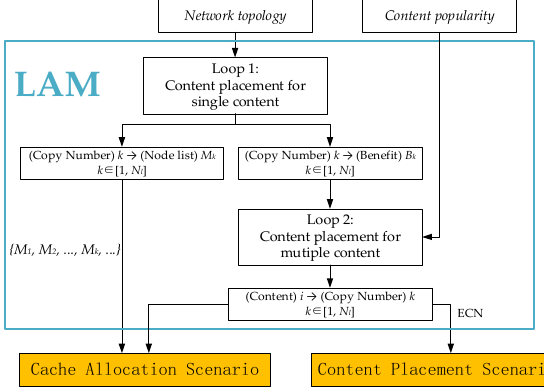
Figure 3. Overview of Lightweight Allocation Method (LAM).